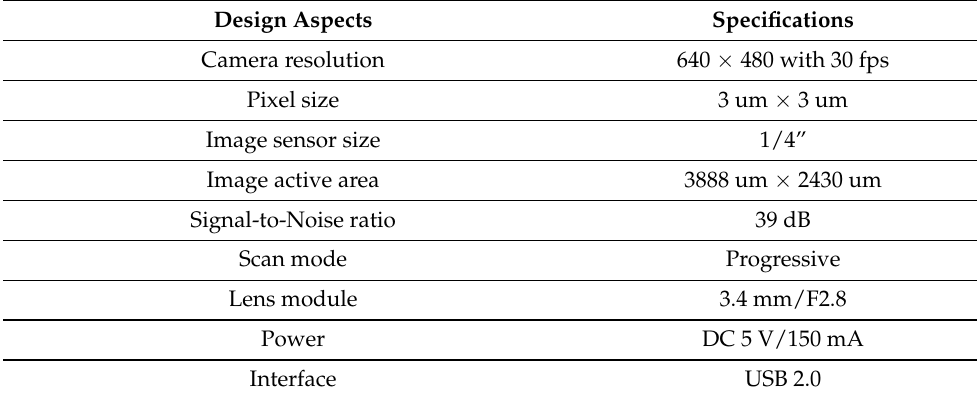
Table 3. Design aspects and specifications of the stereo camera